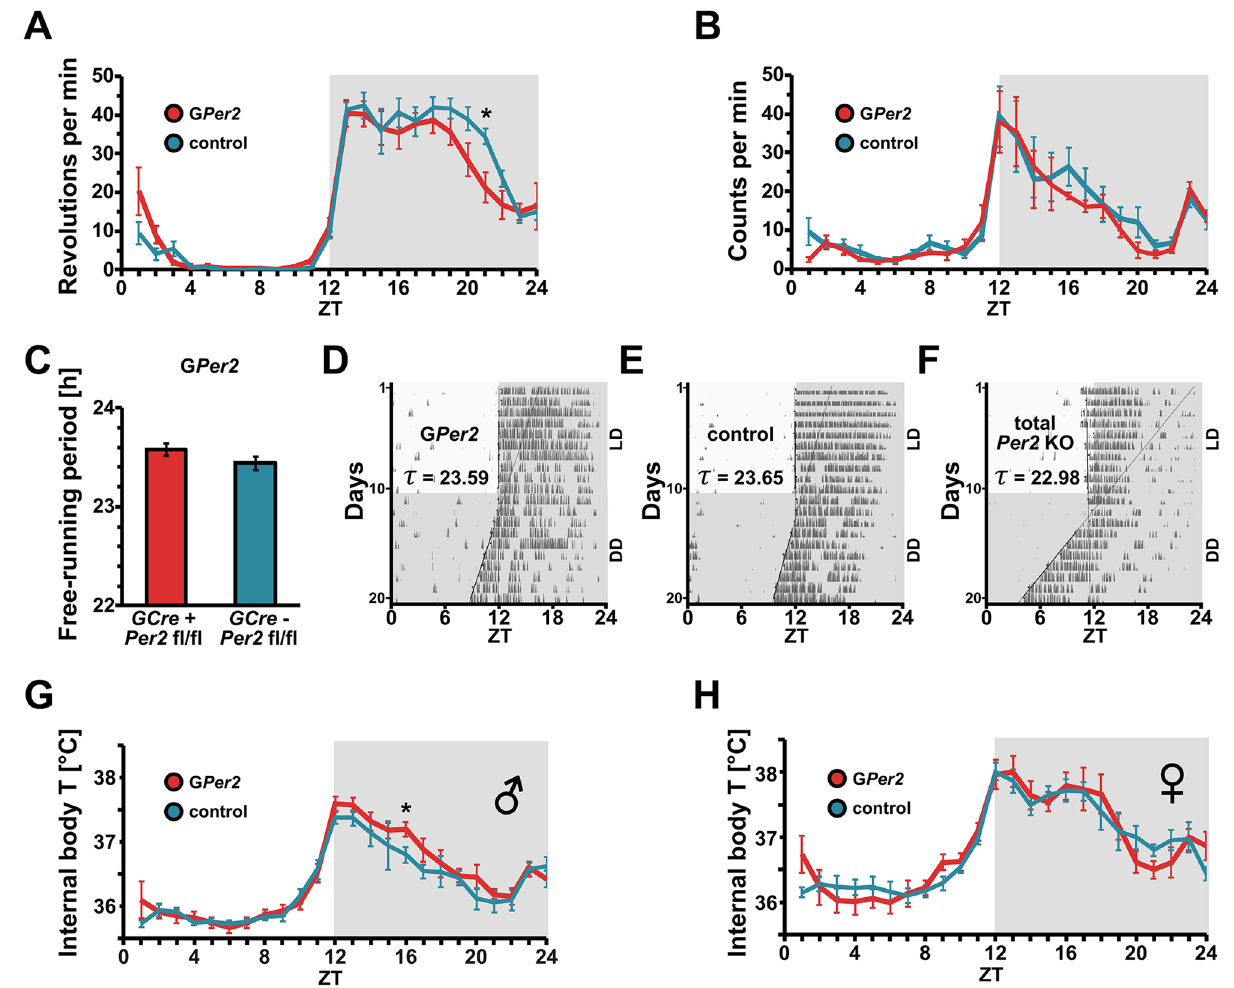
Figure 4. G Per2 mice have a normal circadian clock. ( A ) Wheel-running activity profile of G Per2 ( GCre + Per2 fl/fl , red) and control ( GCre- Per2 fl/fl , blue) mice. The profiles are almost identical with a slight reduction of activity in G Per2 animals at zeitgeber time (ZT) 21. ( B ) General activity pattern of G Per2 (red) and control (blue) mice. The two profiles are not significantly different. ( C ) Circadian period of G Per2 (red) and control (blue) mice. No significant difference was observed between the two genotypes (n = 6, two-tailed t-test, P > 0.05). ( D ) Representative wheel-running actogram of a G Per2 animal. Black vertical marks represent activity in the wheel. Upper part shows the activity under an LD 12:12 cycle. Lower part shows the activity under constant darkness conditions (DD). ( E ) Representative wheel-running actogram of a control animal. ( F ) Representative wheel-running actogram of a whole-body total Per2 knock-out animal. ( G ) Body temperature profile of male G Per2 (red) and control (blue) mice under LD conditions (n = 6). ( H ) Body temperature profile of female G Per2 (red) and control (blue) mice under LD conditions (n =